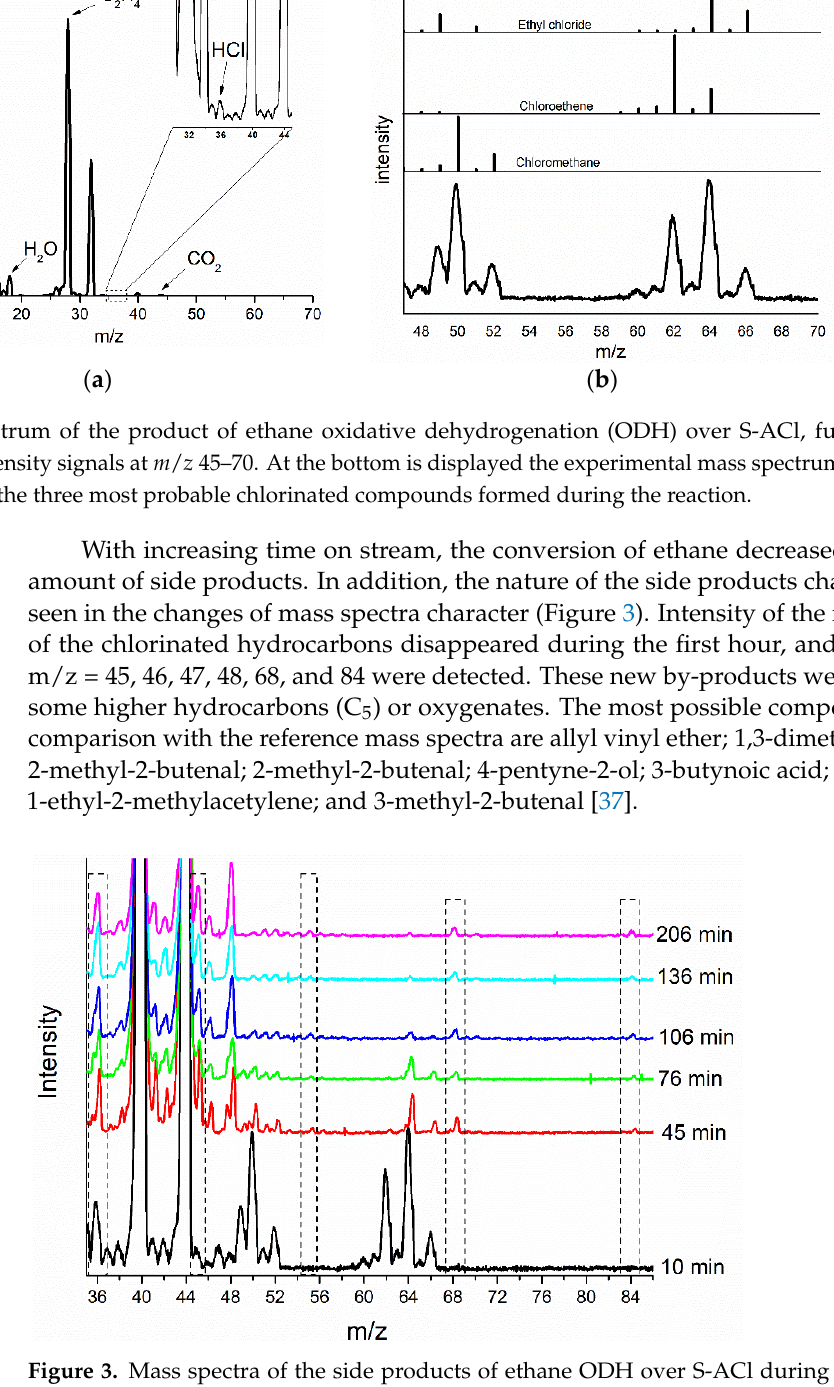
Figure 3. Mass spectra of the side products of ethane ODH over S-ACl during the reaction time including low-intensity signals at m / z 35–86.